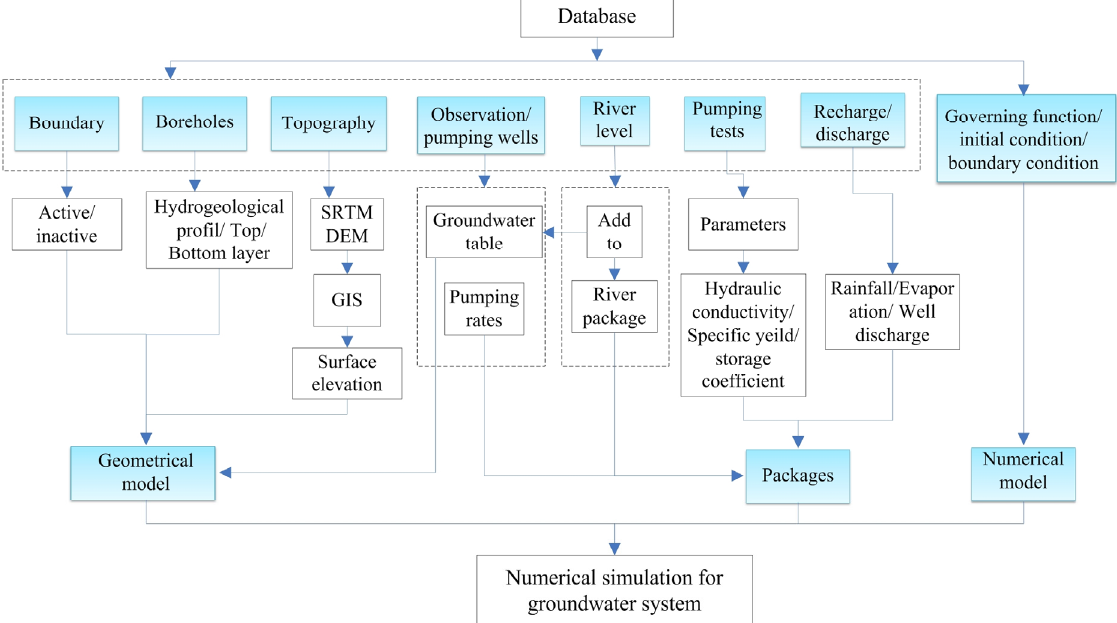
Figure 2. Procedure for data processing and groundwater modeling